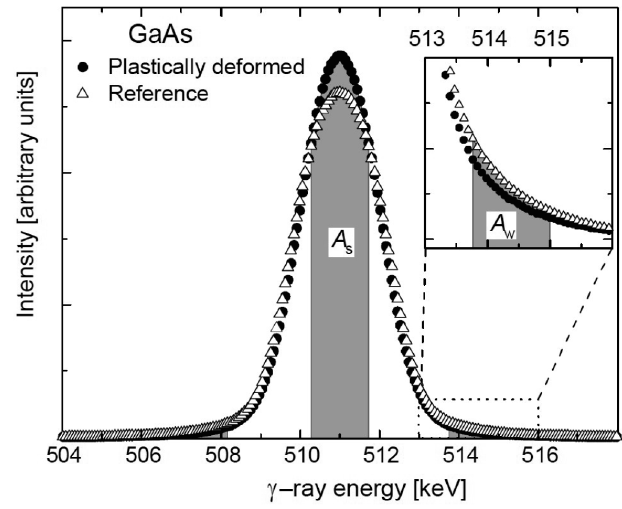
FIG. 3. Doppler broadening example of a positron annihilation radiation line. Dark dots correspond to a GaAs defect-rich sample and show a narrow line [23].